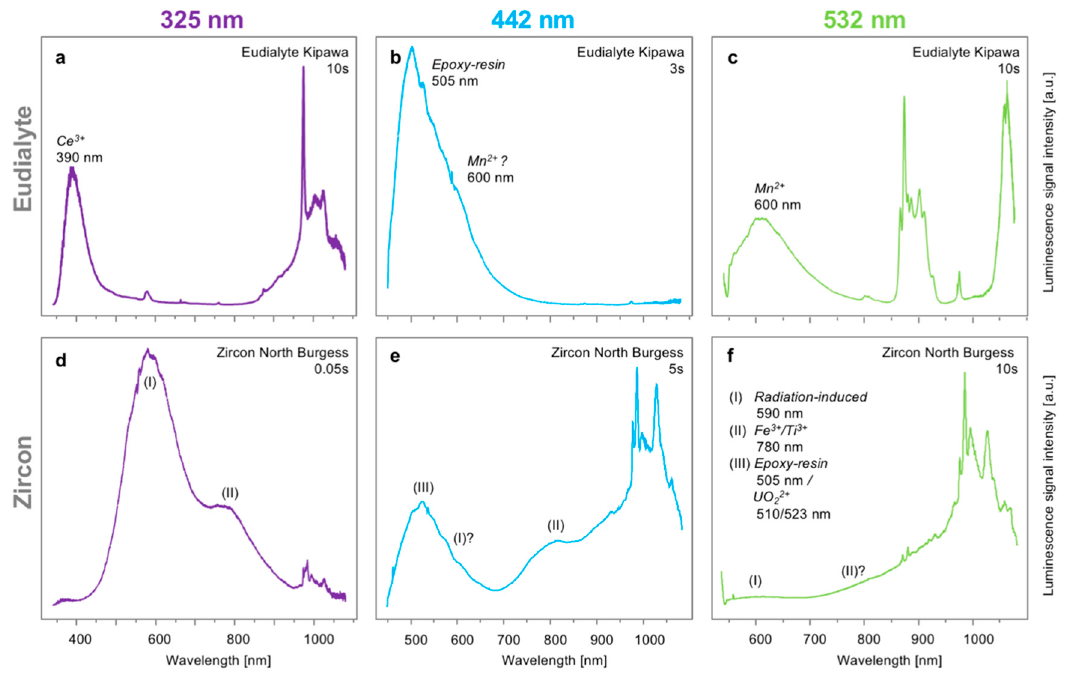
Figure 6. Interpretation of variable broad emission features as a function of excitation wavelength in ( a – c ) eudialyte and ( d – f ) zircon samples. Excitation wavelengths are indicated on top of each plot group.